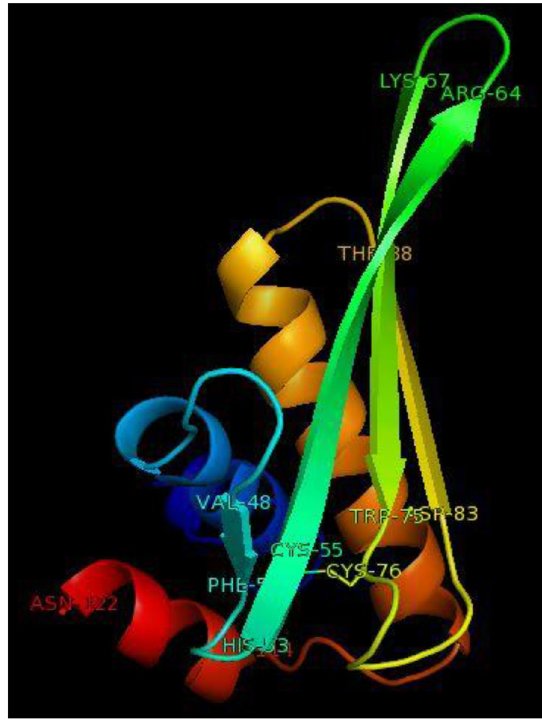
Fig. 8 The diagrammatic representation of the 3D structure of Pp- ALF drawn with PyMOL software using the PDB data generated by Phyre2